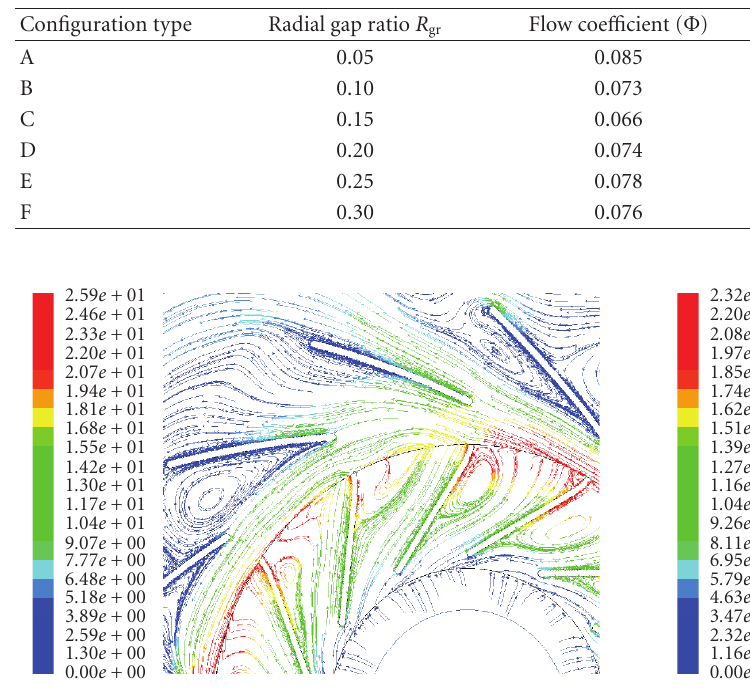
Table 2: Computed flow parameters at design point operation of the fan.